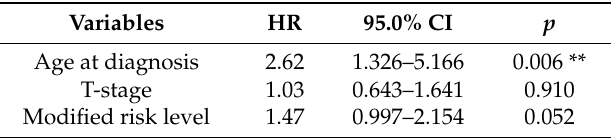
Table 2. Cox multivariable regression analysis on